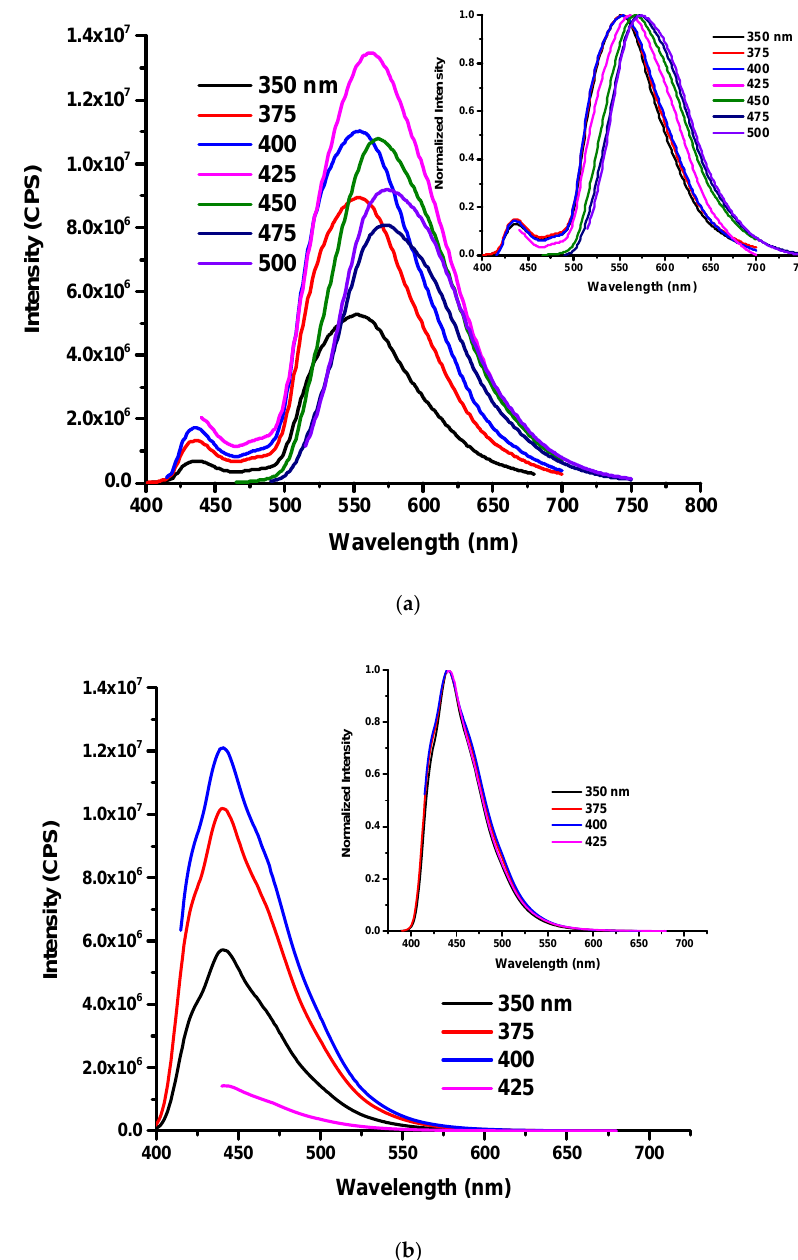
Figure 9. Fluorescence measurement of ( a ) the mixture of O-CDs-SPA in the photopolymer resin with a mass percentage of 25% and ( b ) photopolymer resin.